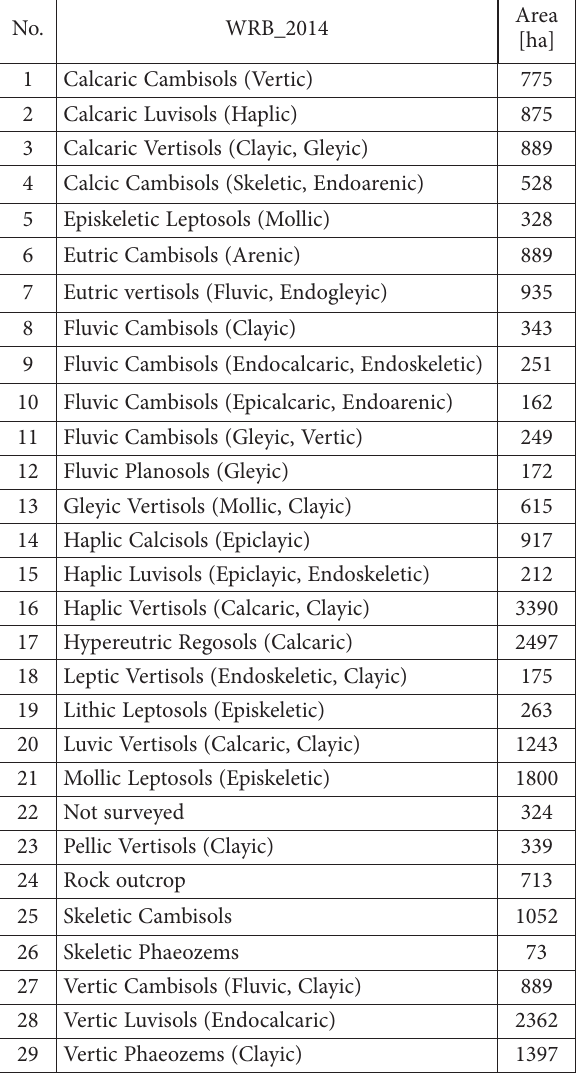
Table 3. The results of the soil